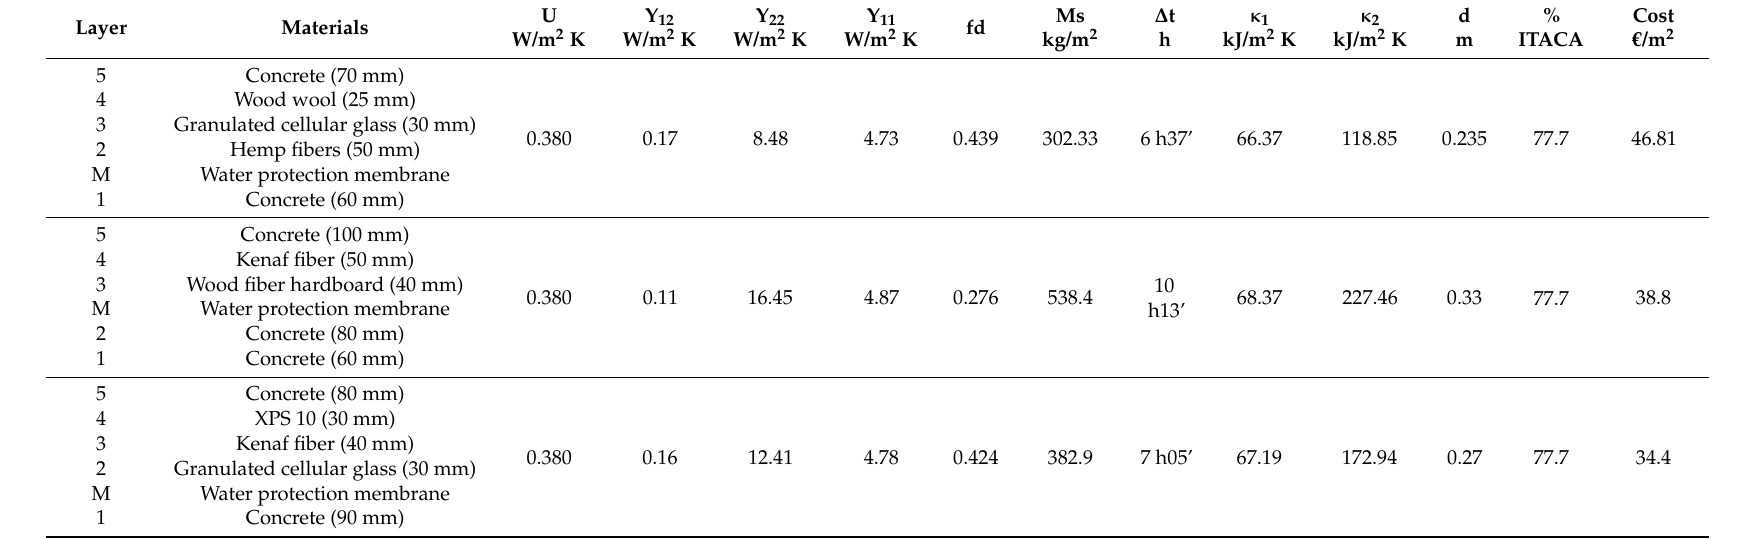
Table 9. Example of high performance slab-on-ground floor with